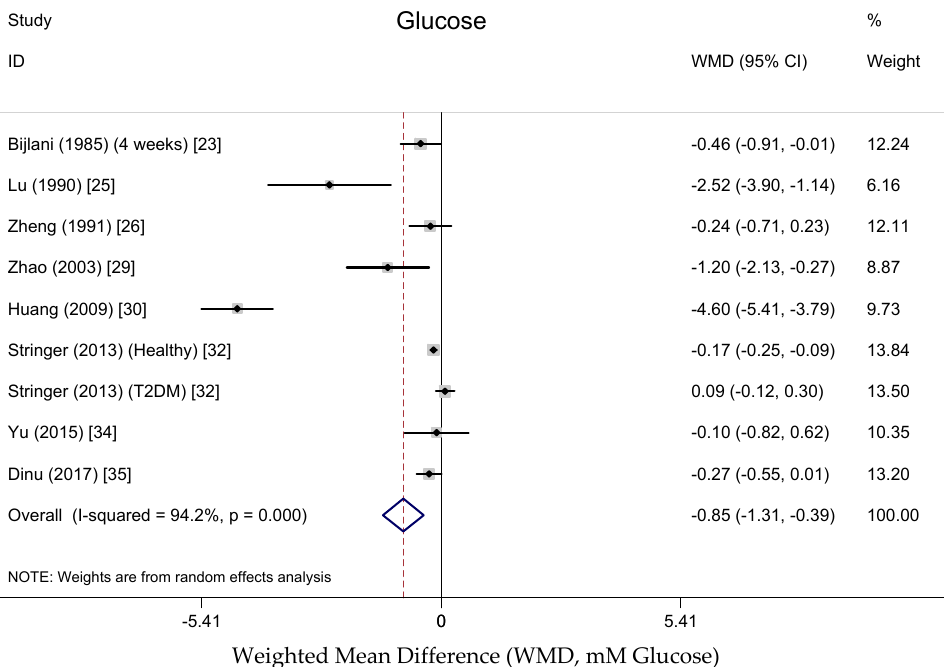
Figure 2. Meta-analysis of the effects of buckwheat products intake on blood glucose concentration compared with baseline or control groups for human studies. Sizes of data markers indicate the weight of each study in the analysis. WMD, weighted mean difference (the results were gained from a random-effects model). Negative values favor a reduction in blood glucose with buckwheat consumption; the dashed line shows the overall WMD value and the size of the rhombus the cumulative effect size and CI.